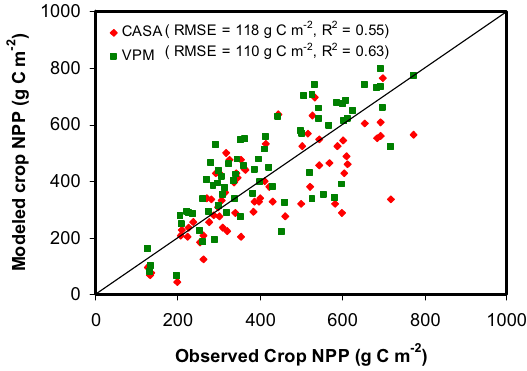
Fig. 4. Comparison of modelled cropland NPP against ground- based NPP The present study also revealed that VPM model with more inputs from satellite could yield similar or improved estimates of cropland NPP over that of previously published estimates of CASA (R 2 = 0.55, RMSE = 118 gC m -2 ). The reason may be the accurate capture of water related constrains on NPP by